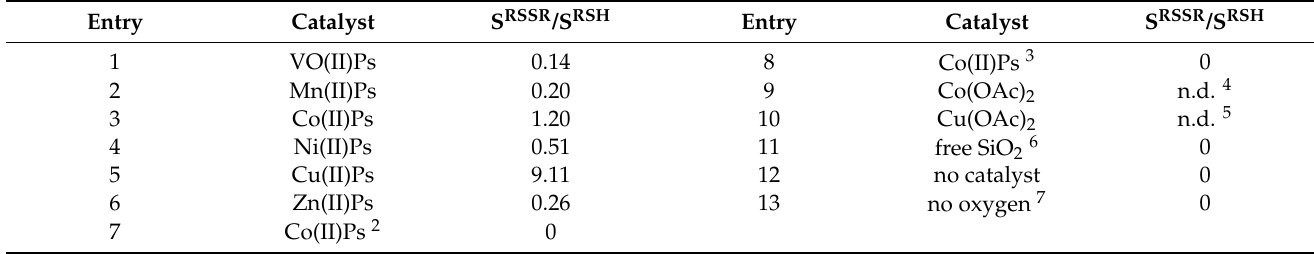
Figure 5. FT-IR spectra of synthesized petroleum metalloporphyrins. Table 1. Catalytic activity of petroleum metalloporphyrins in the Merox reaction 1 expressed as the ratio of the chromato- graphic peak areas of the product (S RSSR ) and unreacted reactant (S RSH